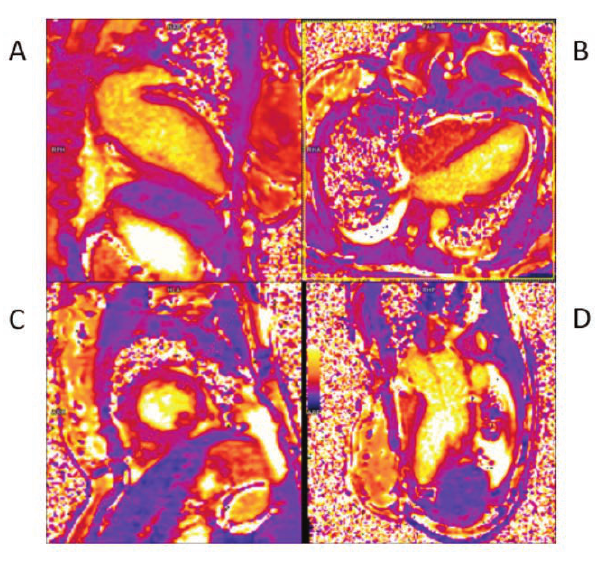
Figure 1. Late gadolinium enhancement showed no contrast uptake of the myocardium and bilateral pleural effusion (right>left). A) 2- chamber long axis; B) 4-chamber long axis; C) short axis at the level of the papillary muscles; D) 3-chamber long axis